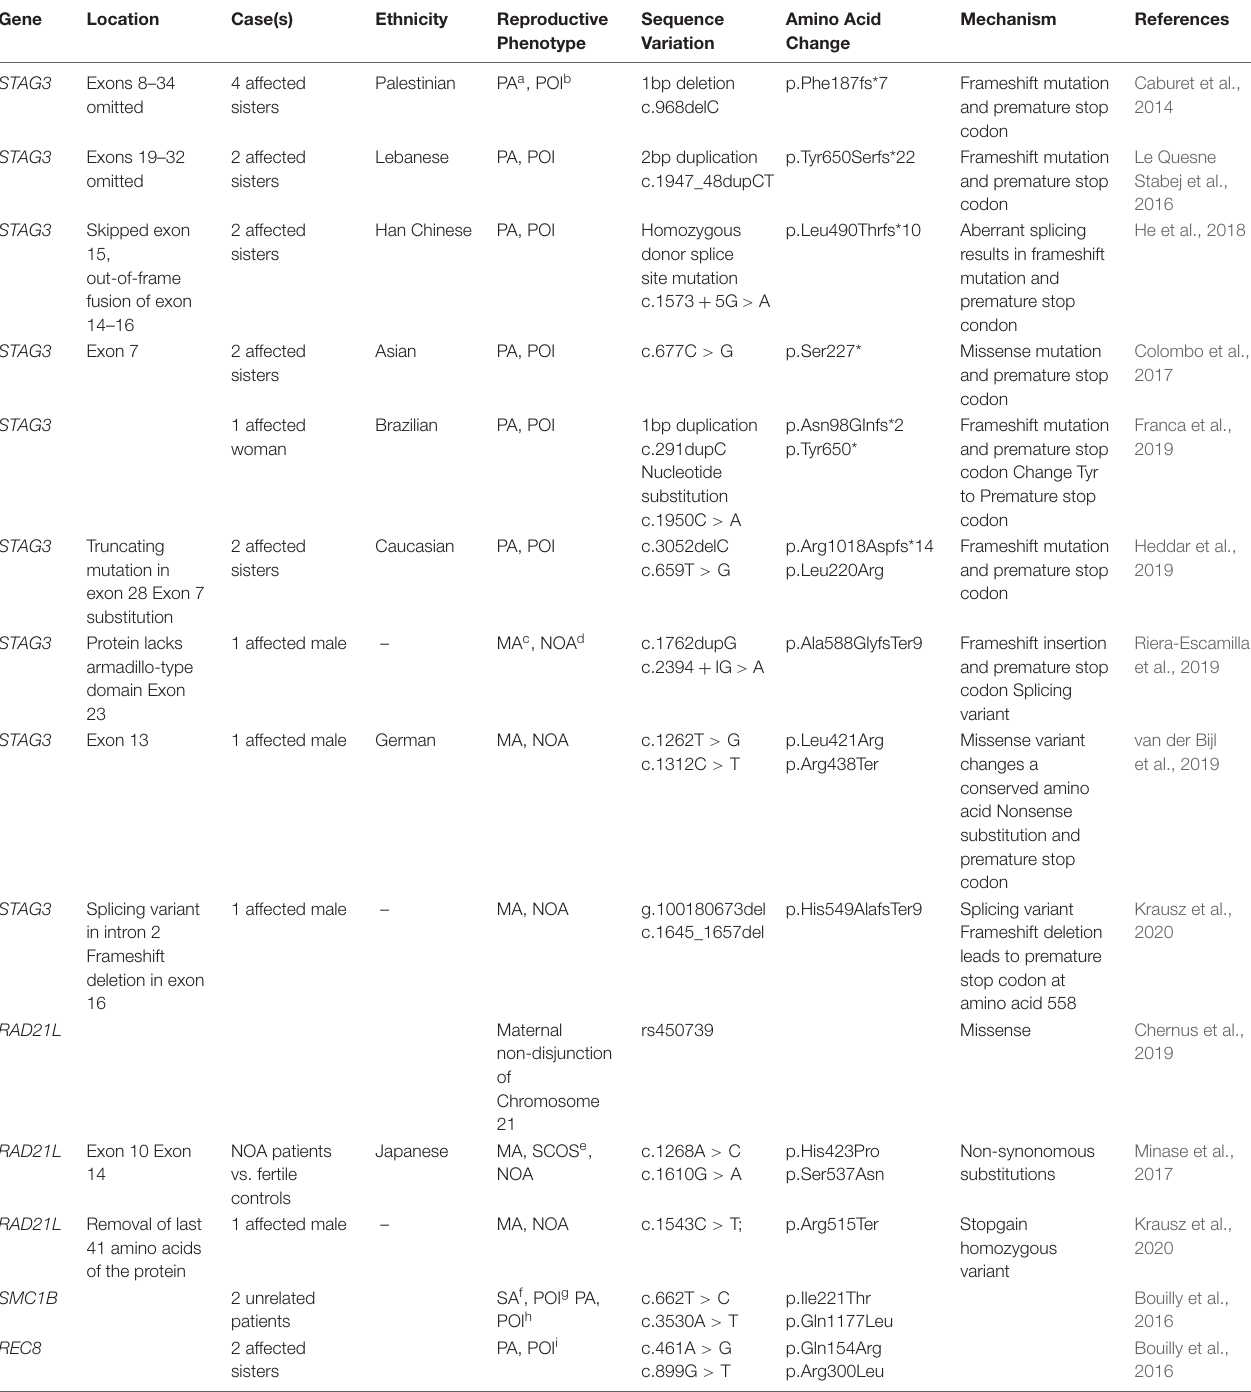
TABLE 1 | Human Cohesin Variants and Reproductive